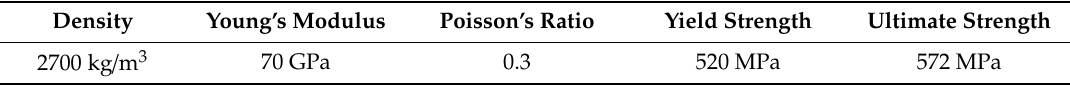
Table 1. Material properties of 7075-T651 aluminum.